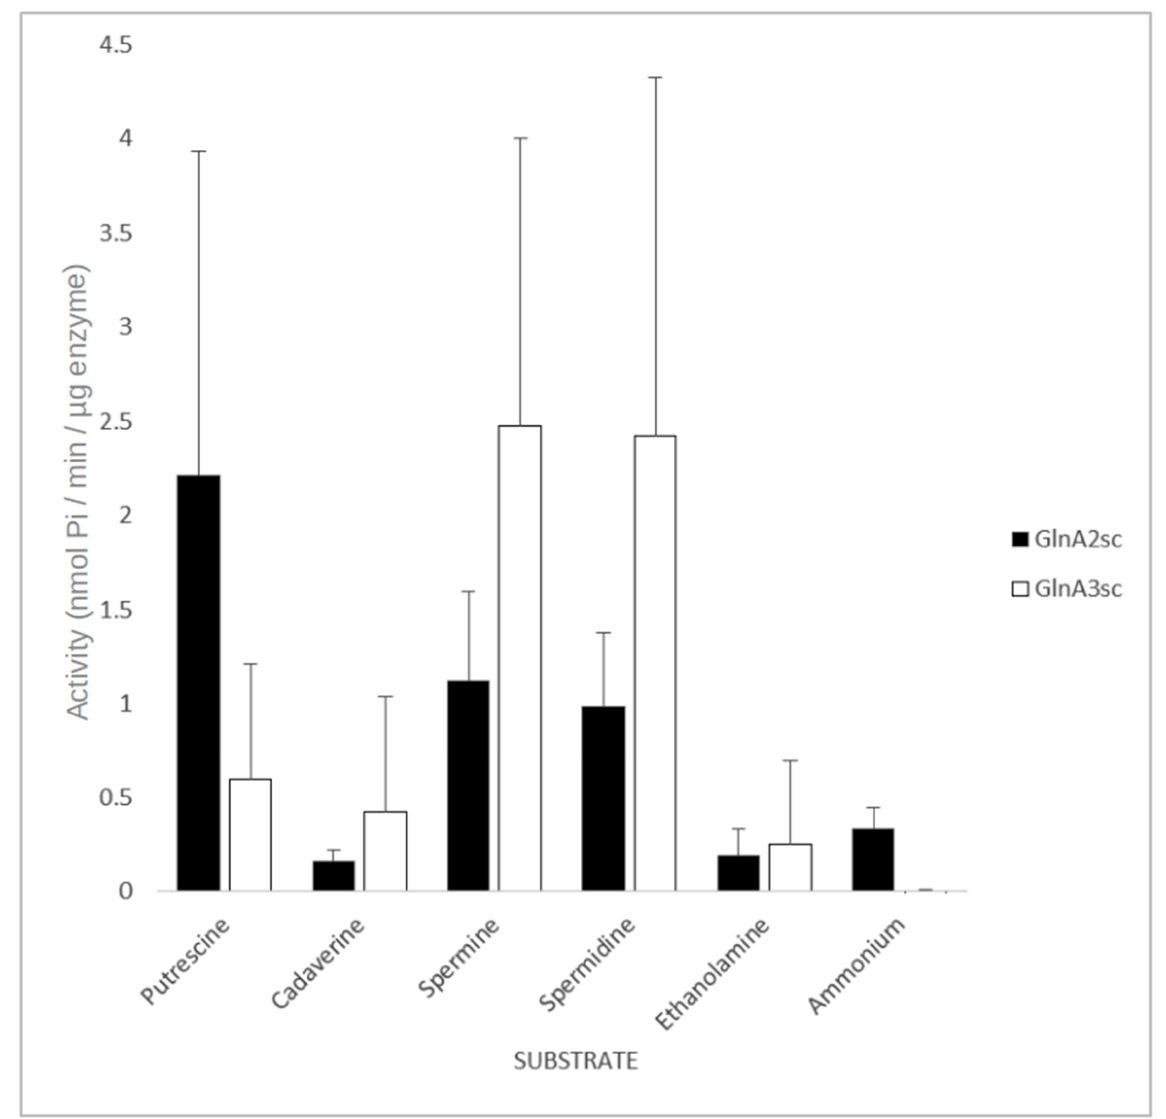
Figure 4. Effect of different amines on the activity of GlnA2 and GlnA3. All substrates were at a concentration of 50 mM. The mean value of n = 6 biological replicates from different cultures with n = 3 technical replicates each with standard error is shown.